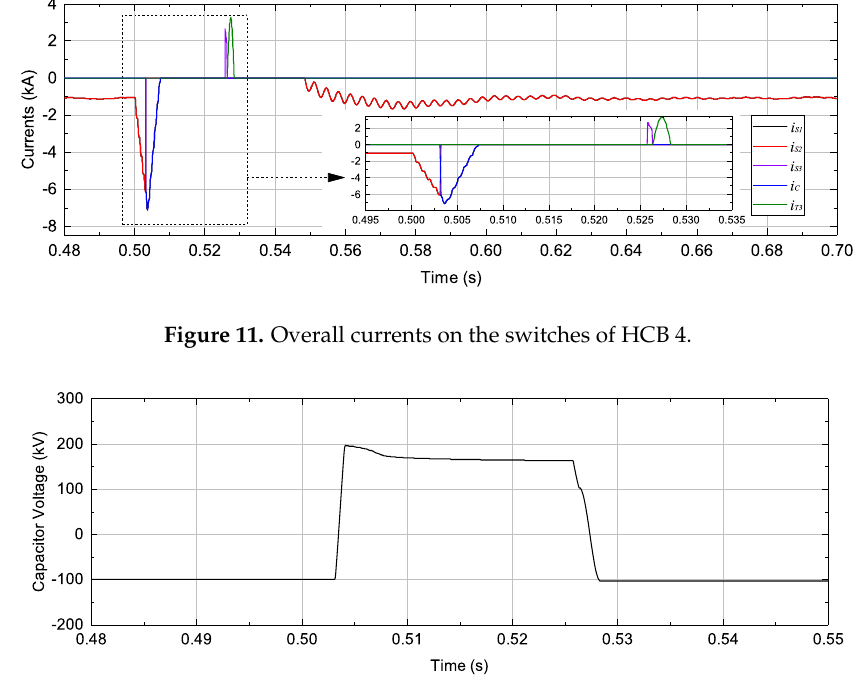
Figure 12. Capacitor voltage in the proposed HCB.